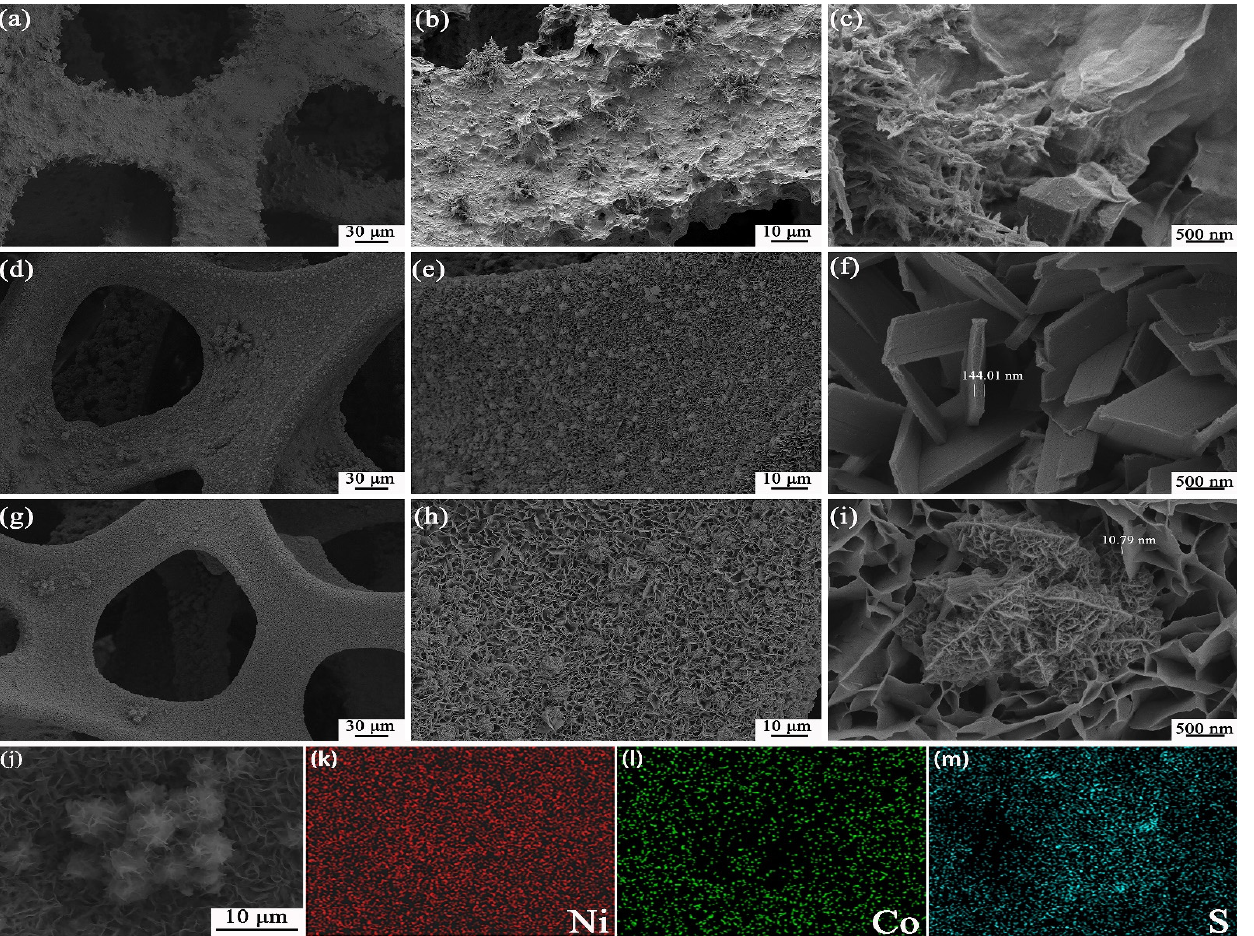
Figure 4. SEM images of the prepared samples: ( a – c ) Ni-S/NF; ( d – f ) Co-S/NF; ( g – i ) NiCo-S/NF; ( j ) FESEM image and the corresponding EDS elemental mappings for ( k ) Ni, ( l ) Co, and ( m ) S. The microstructure of Ni-S, Co-S, and NiCo-S was further investigated by analyzing individual nanosheets via TEM, high-resolution TEM (HRTEM), and selected area electron di ff raction (SAED). The image of the Ni 3 S 2 material for TEM (Figure 5a) showed an irregular ultrathin nanosheet structure, indicating that the loose cone loading in SEM was caused by the stacking of irregular nanosheets. In addition, the HRTEM image (Figure 5b) showed that the la tt ice fringes with a la tt ice distance of 0.238 nm corresponded to the (003) crystal plane of Ni 3 S 2 . Meanwhile, the SAED image shown in Figure 5c, which was in- dexed to the (110) and (122) crystal planes of Ni 3 S 2 in accordance with the di ff raction rings, also suggested that the Ni 3 S 2 substance was polycrystalline. The TEM image of the Co 3 S 4 material (Figure 5d) showed the nanosheet structure under high magni fi cation, which cor- responded to the SEM image. The HRTEM image of the substance (Figure 5e) revealed that the la tt ice fringes with a la tt ice distance of 0.285 nm are in agreement with the Co 3 S 4 (311) crystal plane. The di ff raction ring on SAED (Figure 5f) could be indexed to the (220), (311), (400), and (511) crystal planes of Co 3 S 4 . The image of a single NiCo 2 S 4 nanosheet shown in Figure 5g demonstrated a transparent leaf vein-like morphology, indicating the ultra-thin nature of the material, which is in line with the SEM fi ndings. The dark stripes denoted the foldable edges or nanosheet folds. The image of NiCo 2 S 4 for HRTEM in Figure 5h showed distinct la tt ice fringes with la tt ice distances of 0.235 and 0.216 nm, correspond- ing to the (400) and (311) crystal planes of NiCo 2 S 4 (JCPDS: 73-1704), respectively. Mean- while, the matching SAED pa tt ern depicted in Figure 5i, which features di ff raction rings